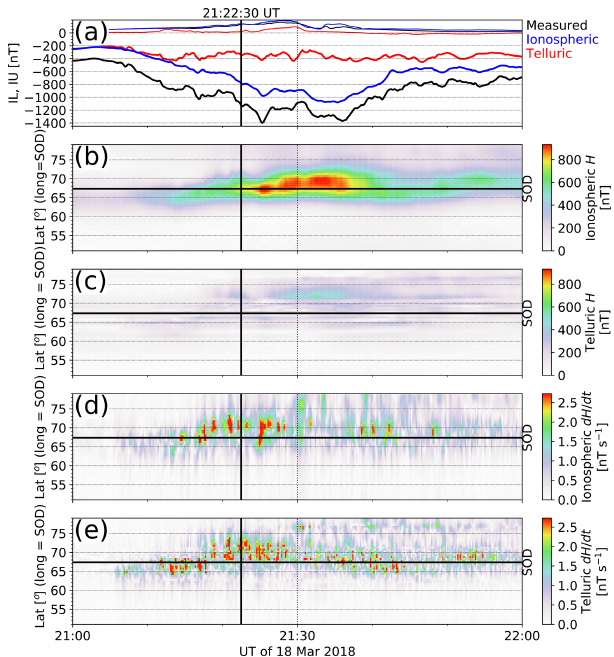
Figure 3. Upper (IU – thin black curve) and lower (IL – thick black curve) envelope curves of the magnetic field x component measured by IMAGE as a function of UT on 18 March 2018 at 21:00–22:00UT. (a) IL and IU derived from the separated iono- spheric and telluric parts of the magnetic field are shown in blue and red, respectively. Latitude profiles of ionospheric contribution to horizontal ground magnetic field (b) , telluric contribution to hor- izontal ground magnetic field (c) , ionospheric contribution to the time derivative of the horizontal ground magnetic field (d) , and tel- luric contribution to the time derivative of the horizontal ground magnetic field (e) along the longitude (long) of SOD as a function of UT. The black horizontal line indicates the latitude of SOD, and the black vertical line indicates the time shown in Fig.